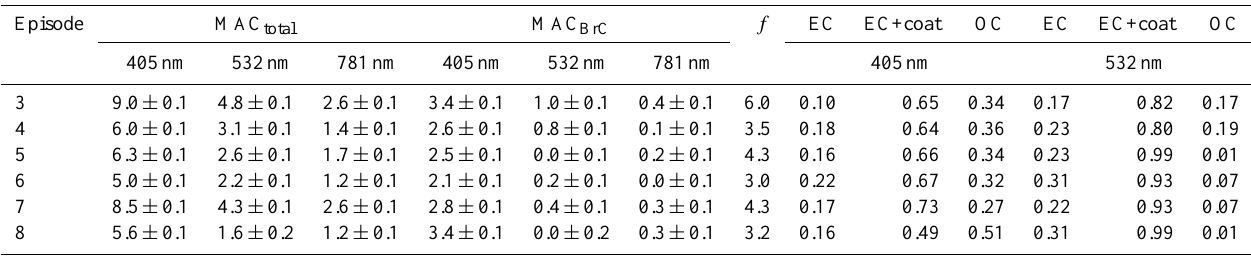
Table 3. Mass Absorption Cross Sections (MAC total ) , brown carbon MAC (MAC BrC ) , enhancement factor ( f ) , and percent contribution to total absorption [ β abs (405nm) and β abs (532nm)] for Asian transport episodes observed during CAPMEX.